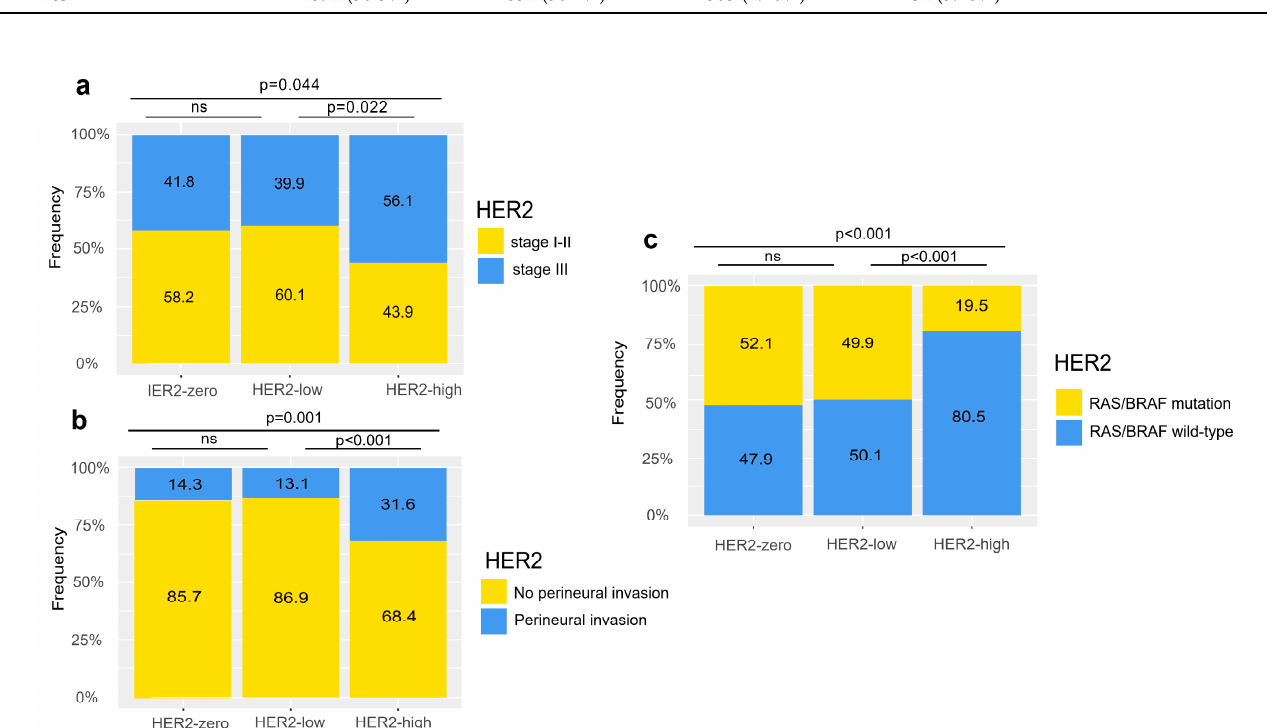
Figure Figure 3. HER2 subgroups had different clinical features, including ( a ) pathological stage, ( b ) perineural invasion, and ( c ) RAS/BRAF mutation. Table 1. Baseline clinicopathological characteristics of the overall cohort.